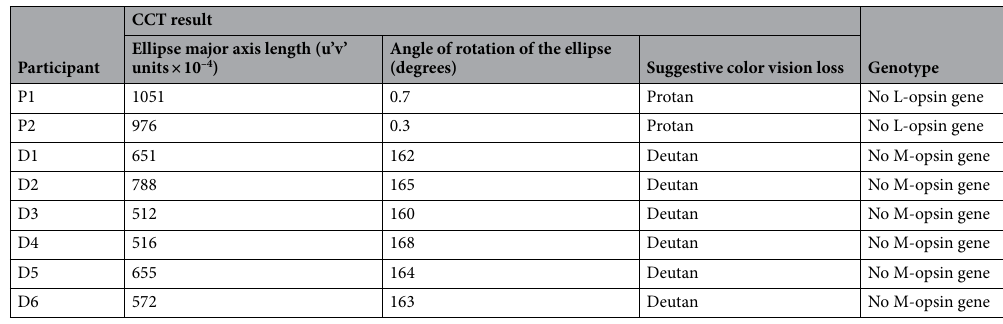
Table 1. Results of the color vision characterization of the dichromats/anomalous trichromat participants.